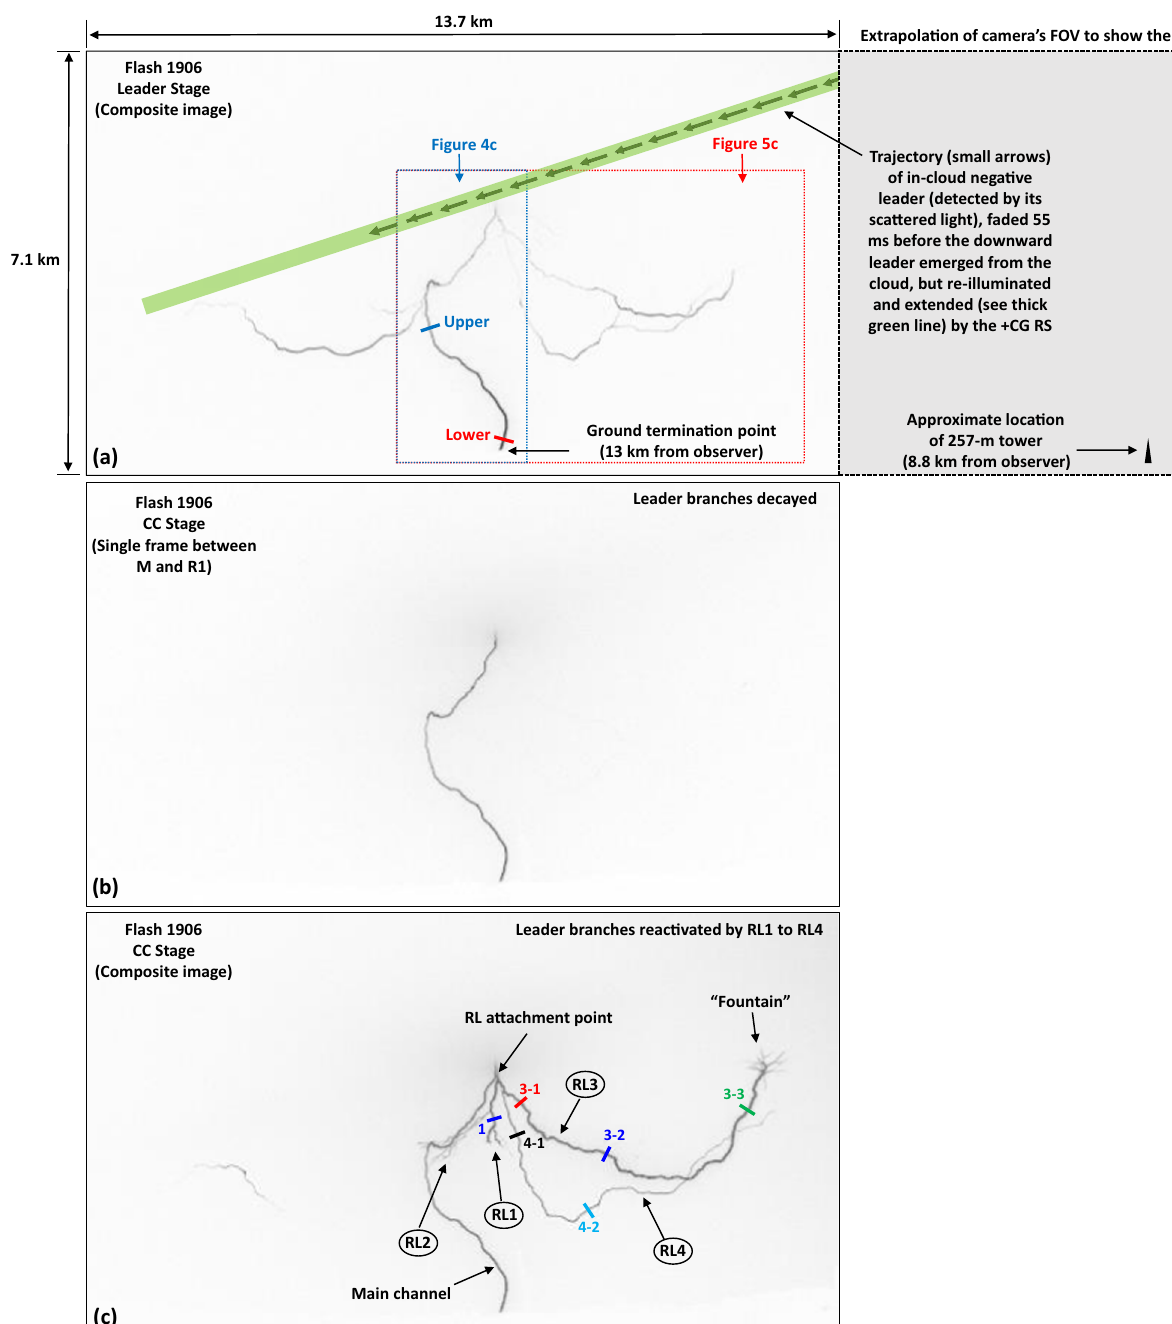
Fig. 2 Single-stroke positive Flash 1906. a Composite image of the leader stage (1000 50- µ s frames), b selected continuing current (CC) stage frame between M-component (M) and luminosity dip R1 with all leader branches decayed, and c the CC stage (900 50- µ s frames) showing leader branches reactivated by recoil leaders RL1 to RL4. Extrapolation of camera ’ s fi eld of view in a is based on the known locations of both the + CG termination point and the 257-m tower (see Fig. 1a). Two overlapping red and blue dotted-line boxes in a show the regions for which individual frames are presented. Two channel cross-sections, for which luminosity variations as a function of time are analyzed, are marked “ Upper ” and “ Lower ” in a . Four branches reactivated by recoil leaders during the CC stage are marked, in the order of their occurrence, in c . Also marked in c is the main channel, the point at which each of the four recoil leaders attached to the main channel, and branch cross-sections for which luminosity variations as a function of time are shown in Supplementary Note